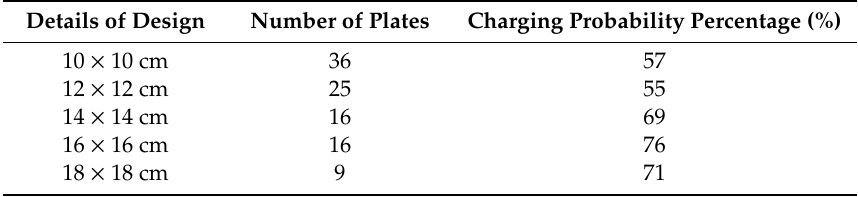
Table 3. Charging probability with di ff erent plate